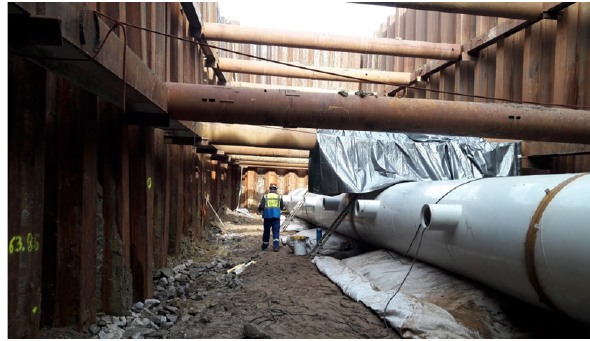
Figure 3: The discharge system during